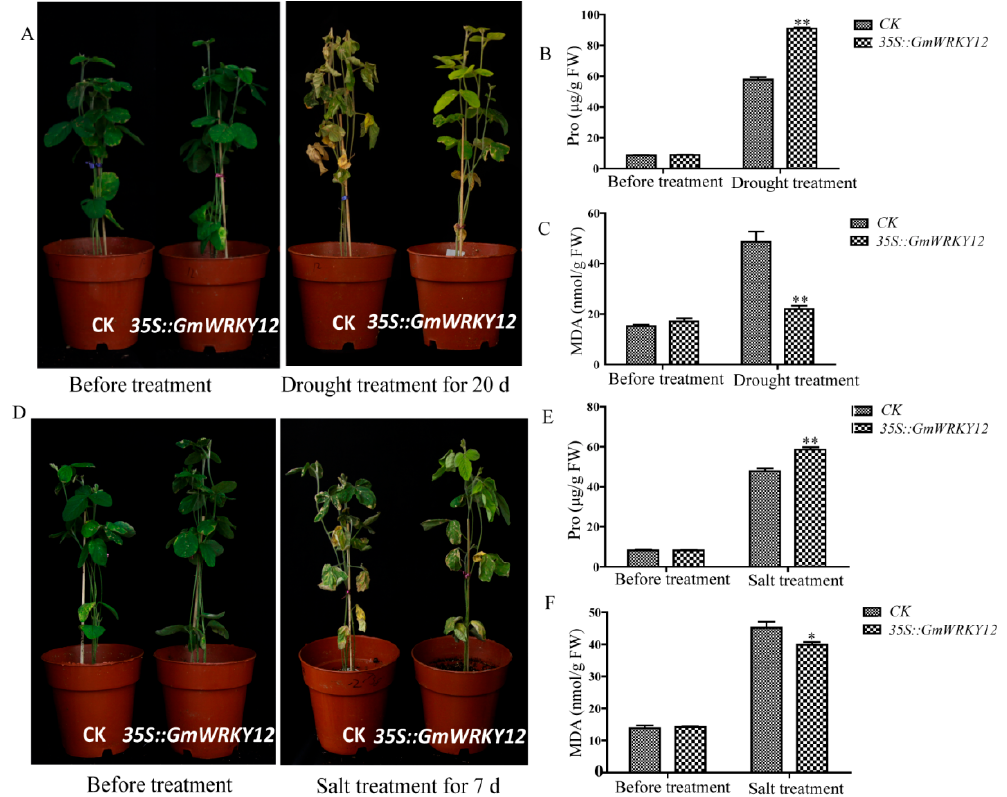
Figure 7. Phenotype identification of GmWRKY12 under drought and salt treatments. ( A ) Images of drought stress resistance phenotypes of CK and 35S::GmWRKY12 soybean seedlings after drought